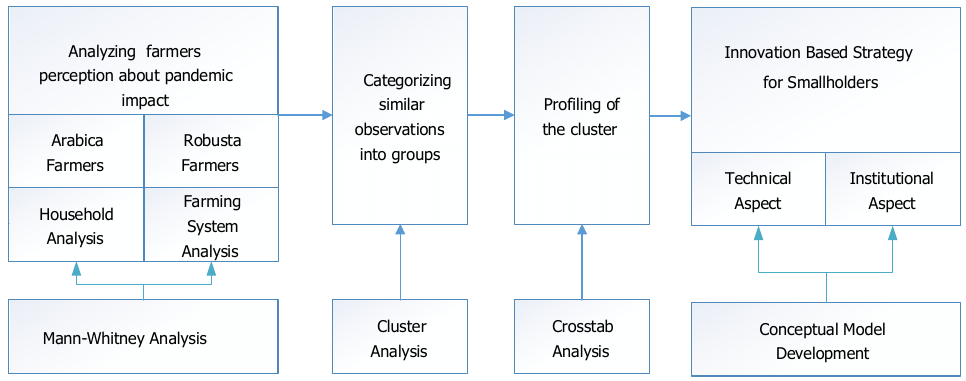
Figure 2. Analysis stages and method of analysis.